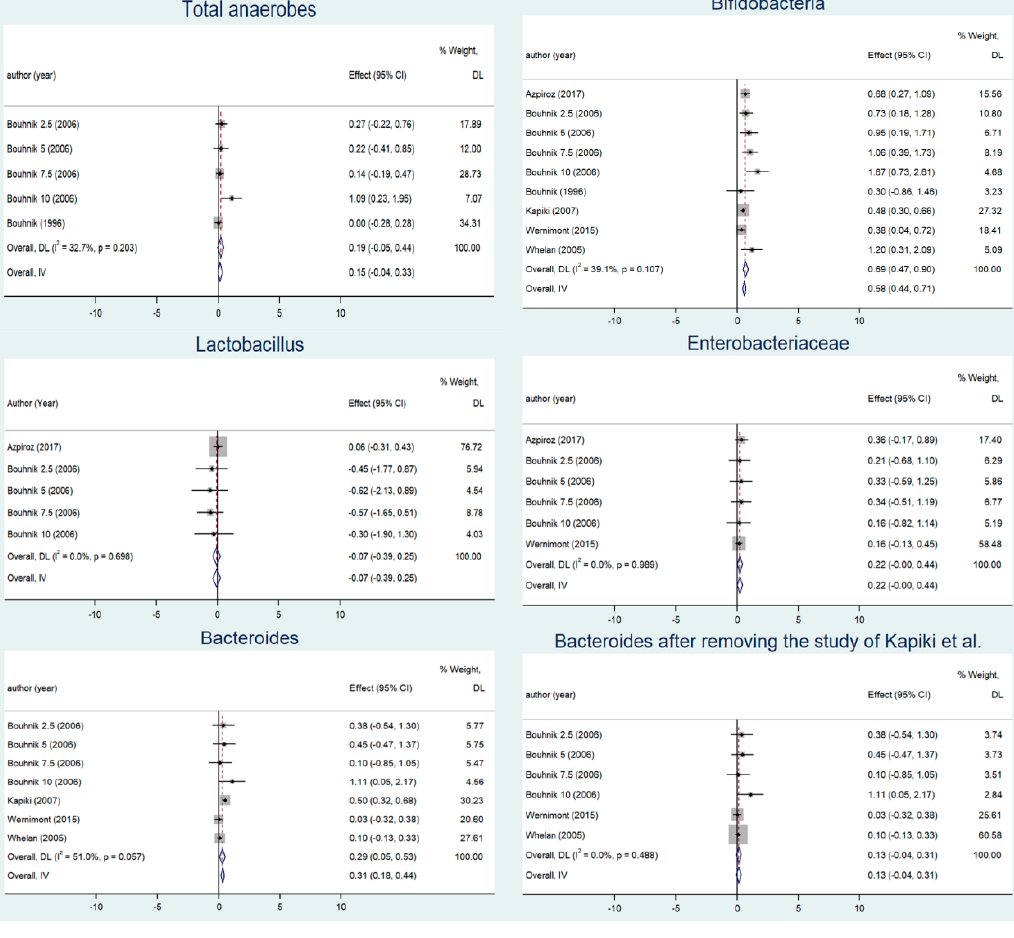
Figure 2. Summary analysis of changes in intestinal flora before and after supplementation